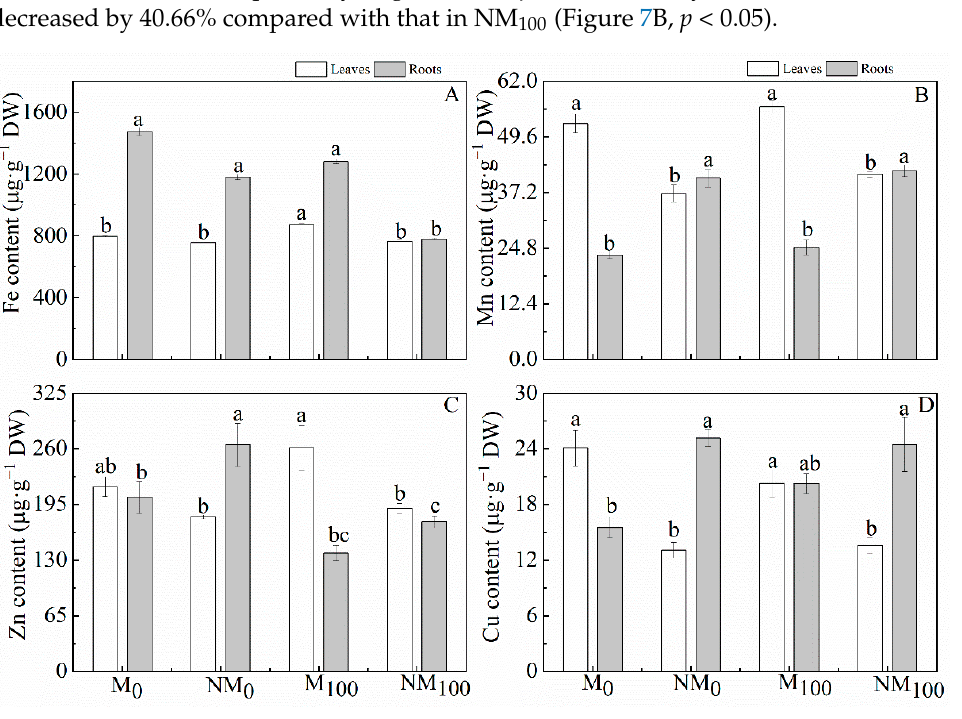
Figure 7. Changes in the contents of iron (Fe, ( A )), manganese (Mn, ( B )), zinc (Zn, ( C )), and copper (Cu, ( D )) in leaves and roots of Neva irrigated with or without magnetized water following exposure to 0 or 100 µ mol · L − 1 cadmium stress. Values are the means ± SE of at least three replicates. Different lowercase letters indicate significant differences among the four treatments at the 0.05 level in leaves and roots.